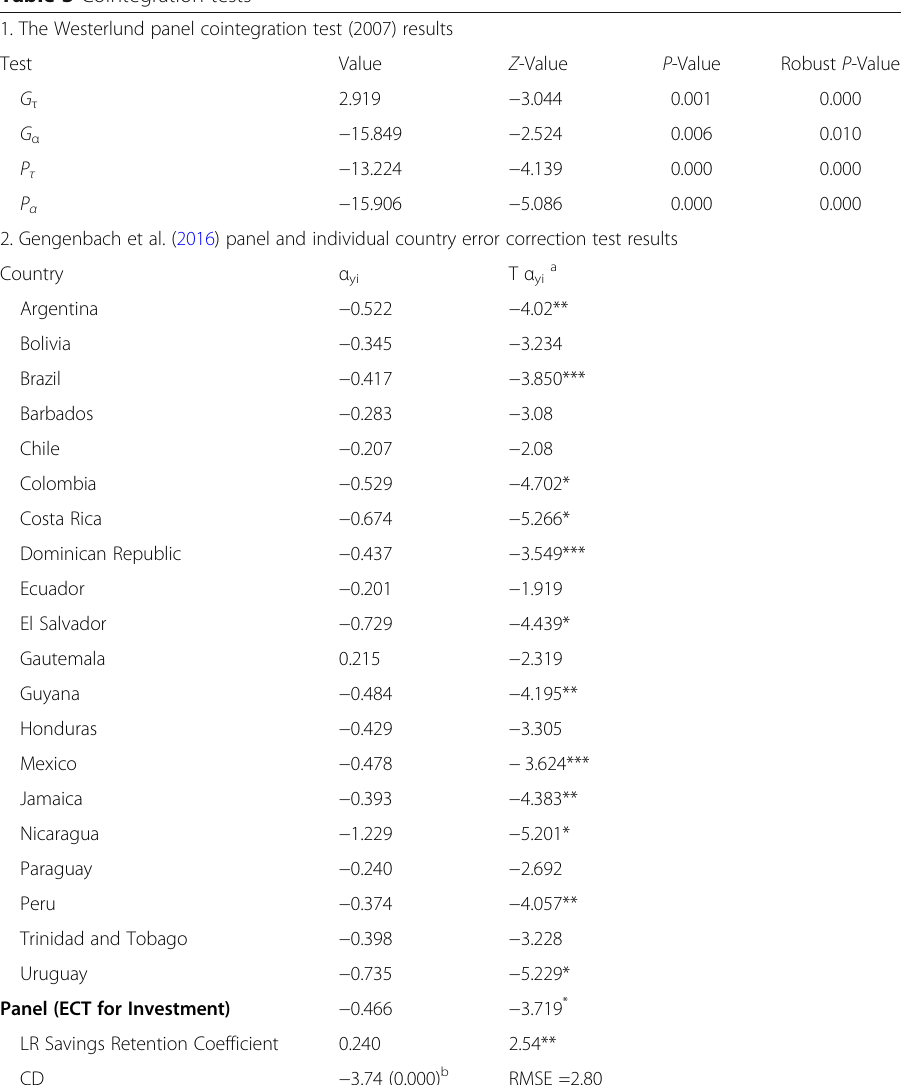
Table 3 Cointegration tests 1. The Westerlund panel cointegration test (2007)